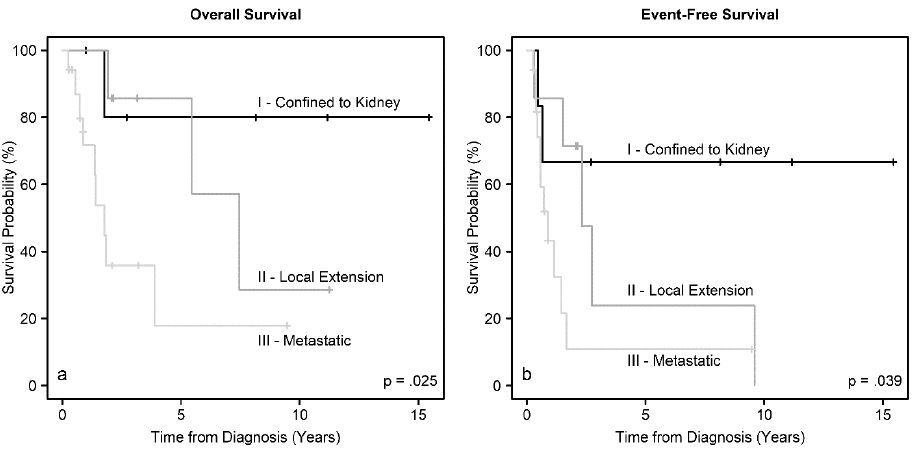
Figure 2. Overall survival and event-free survival distributions according to the disease group.